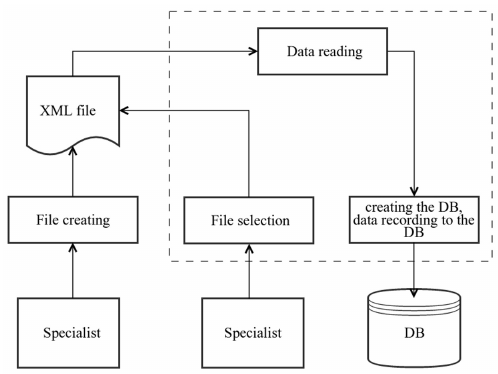
Fig. 2. The scheme of converting the XML file to a database file.